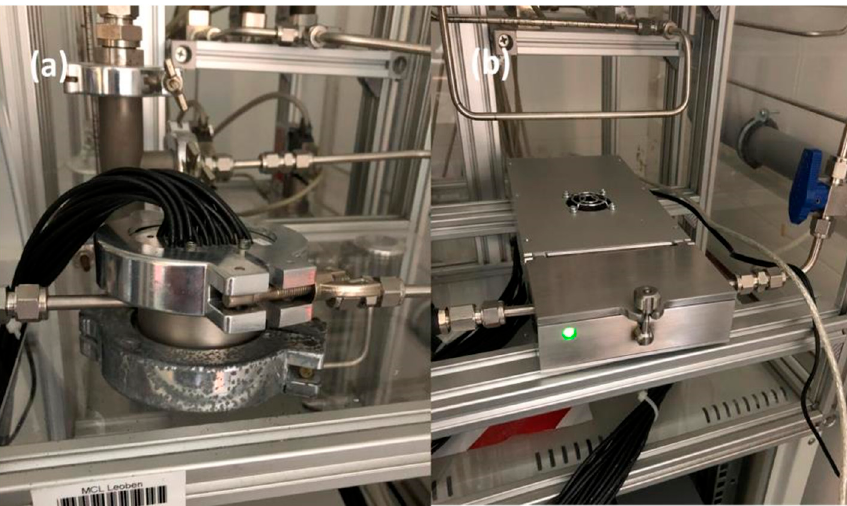
Figure 2. ( a ) MCL Box I setup with the gasflow from the right to left. The cables lad to external data and control tools. ( b ) Box II with integrated electronics, special designed to work with CMOS gas